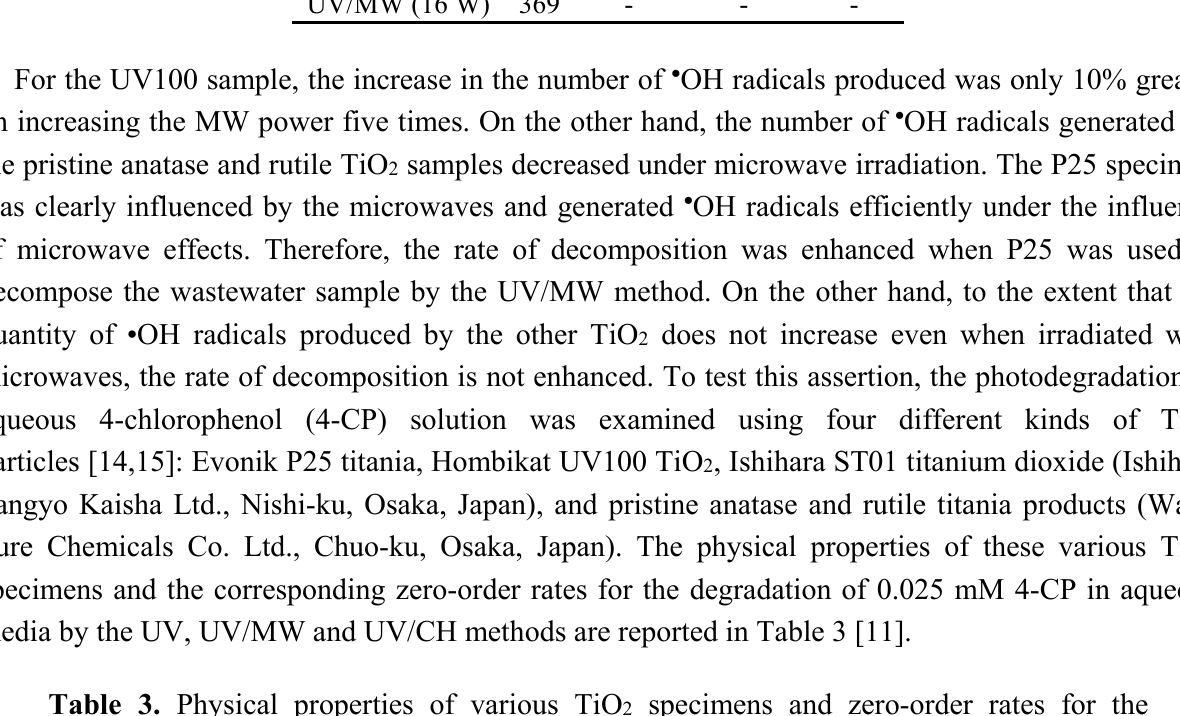
Table 3. Physical properties of various TiO 2 specimens and zero-order rates for the degradation of 4-chlorophenol (4-CP: 0.025 mM) using several methods: namely, the UV, UV/MW and UV/CH methods. Reproduced from [11]. Copyright 2009 by Copyright 2002 by the American Chemical